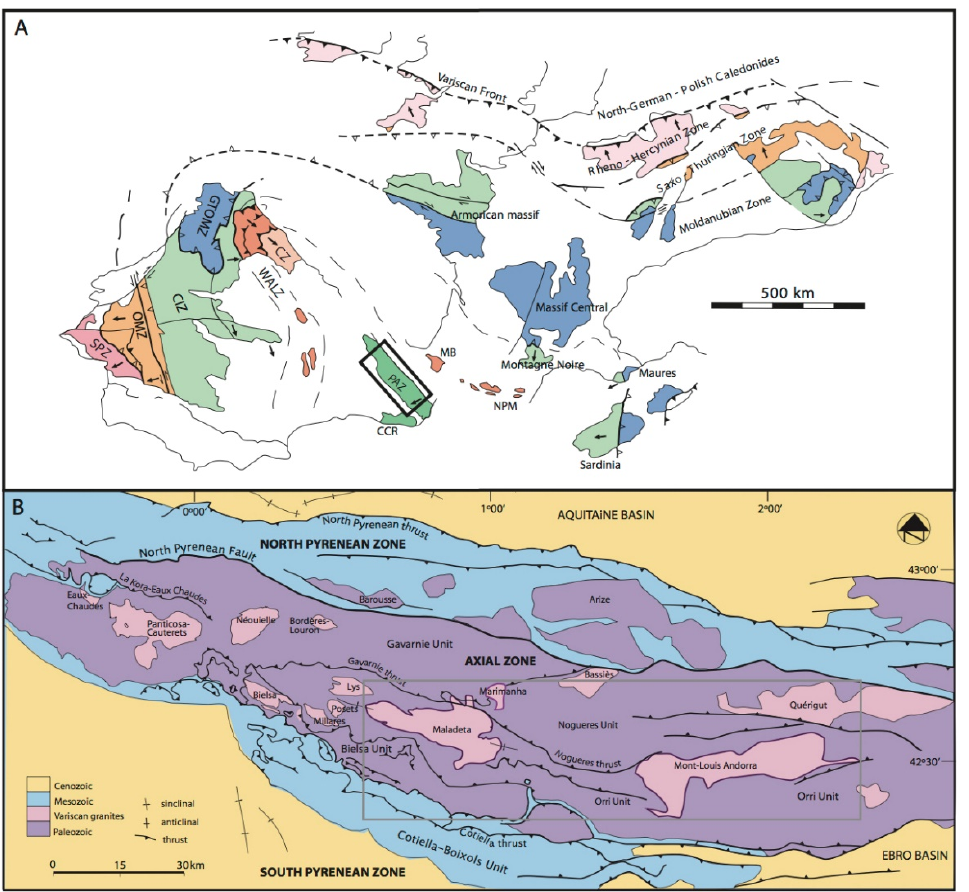
Figure 1. ( A ) European Variscan belt (Modified after Franke [96]); CZ-Cantabrian Zone, WALZ-West Asturian-Leonese Zone, GTOMZ-Galicia Tras-os-Montes Zone, CIZ-Central Iberian Zone, OMZ-Ossa Morena Zone, SPZ-Southportuguese Zone, PAZ-Pyrenean Axial Zone, CCR-Catalonian Coastal Ranges, NPM-Nord-Pyrenean Massifs, MB-Massifs Basques. ( B ) Geological sketch map of the Central part of the Pyrenees, showing the situation of the Pyrenean granites.